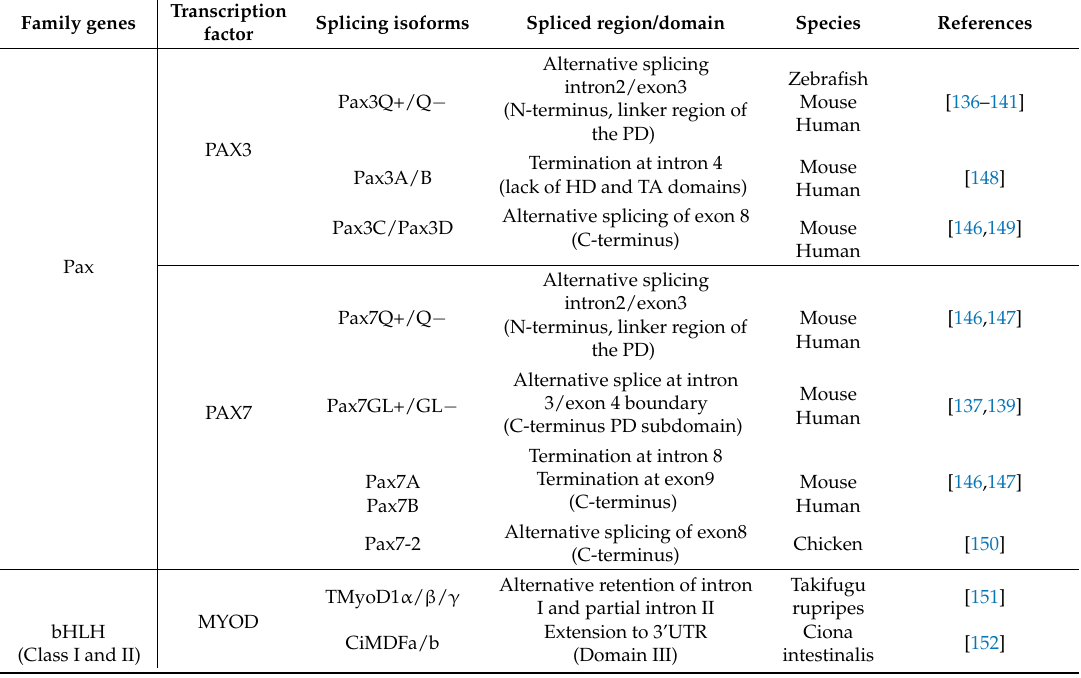
Table 1. Alternative Splicing (AS) of myogenic Transcription Factors: the table provides splicing mechanisms, species and references for the described transcription